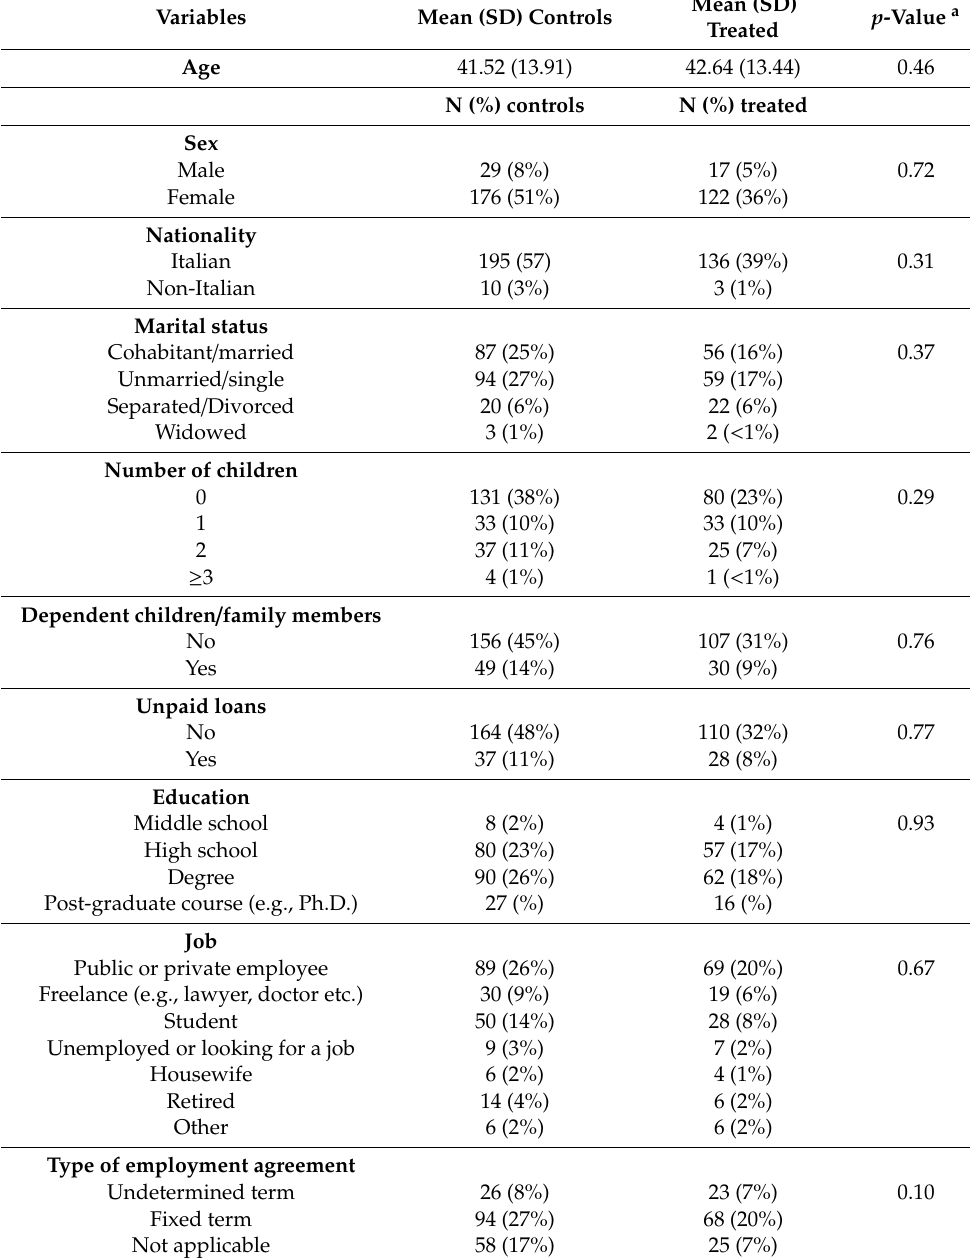
Table 1. Baseline characteristics of the analysed